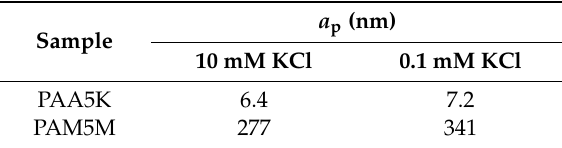
Table 1. Hydrodynamic diameters ( a p ) of polymers estimated by the Einstein’s viscosity equation. All measurements were conducted at a controlled temperature of 20 °C and initial PAA5K and PAM5M concentrations of 50 mg/L.